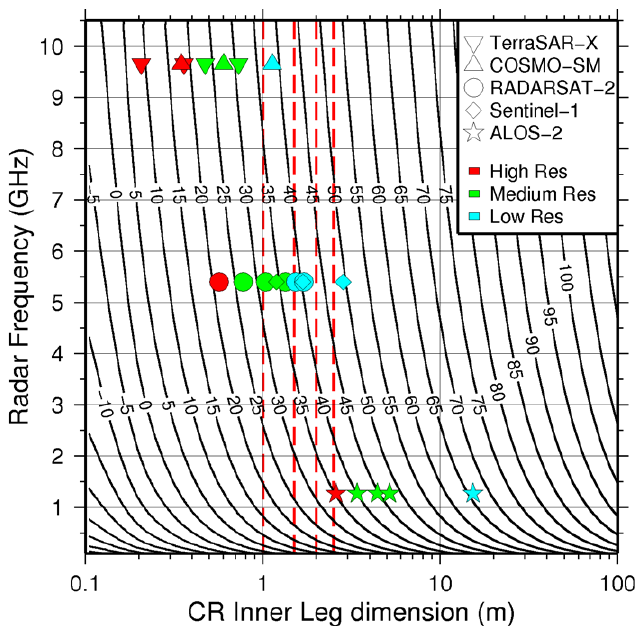
Figure 4 Figure 4. Contour plot of peak theoretical RCS (in units of dBm 2 ) for TCR at microwave frequencies between L and X-band. Plotted symbols represent the required RCS estimates for the SAR sensors and imaging modes given in Table 1 based on a design tolerance of 0.1 mm LOS displacement error. Red dashed lines indicate the size of TCR manufactured and tested in this